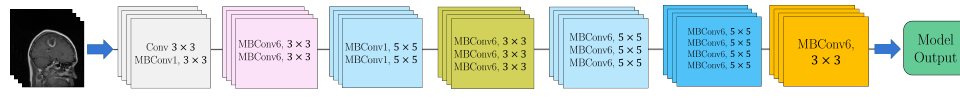
Figure 6. A basic representation of pre-trained EfficientNetB0 architecture.